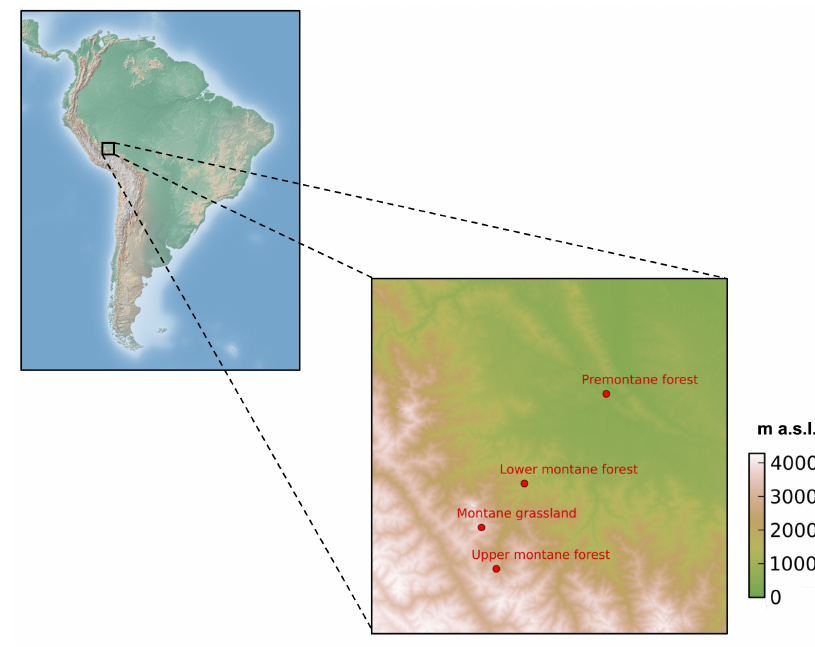
Figure 1. Map of study sites across the Kosñipata Valley, Manu National Park,